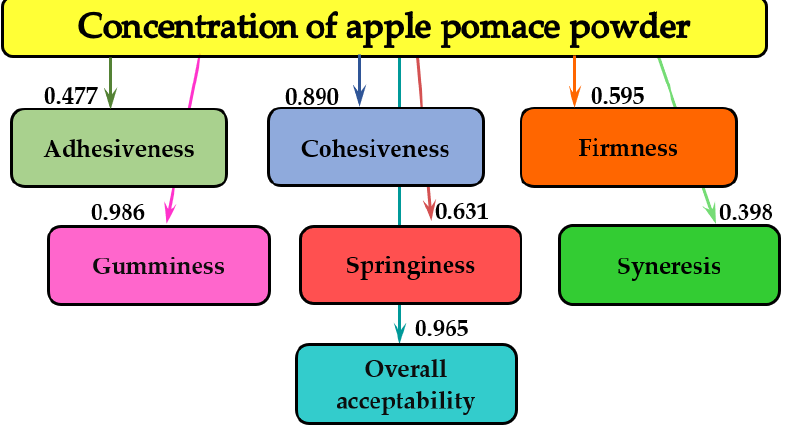
Figure 2. The informational analysis for the influence of concentration of AP powder on textural parameters and overall acceptability of yogurt.